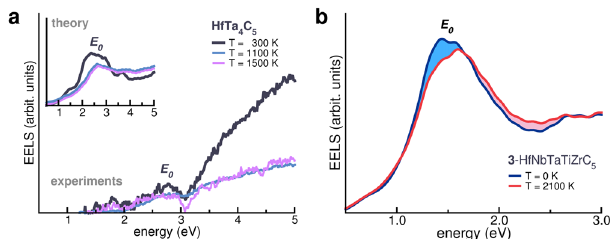
b Simulated EELS for a representative POCC structure at increased transferred momentum q in units of2 π / a 0 . c Plasmonenergy E 0 ( q ) dispersion relation. Yellow circles arethe calculated crossoverenergies from b ) whilethe blackdashedline is the corresponding quadratic fi t. Source data are provided as a Source Data fi le.